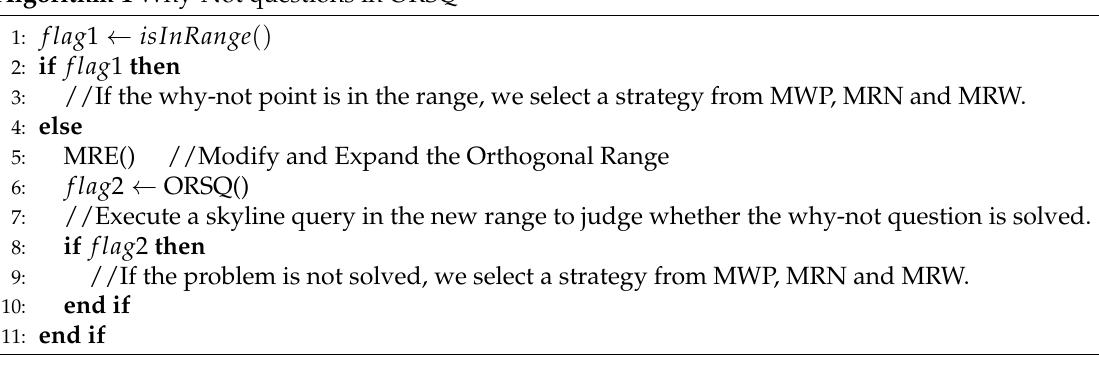
Algorithm 1 Why-Not questions in